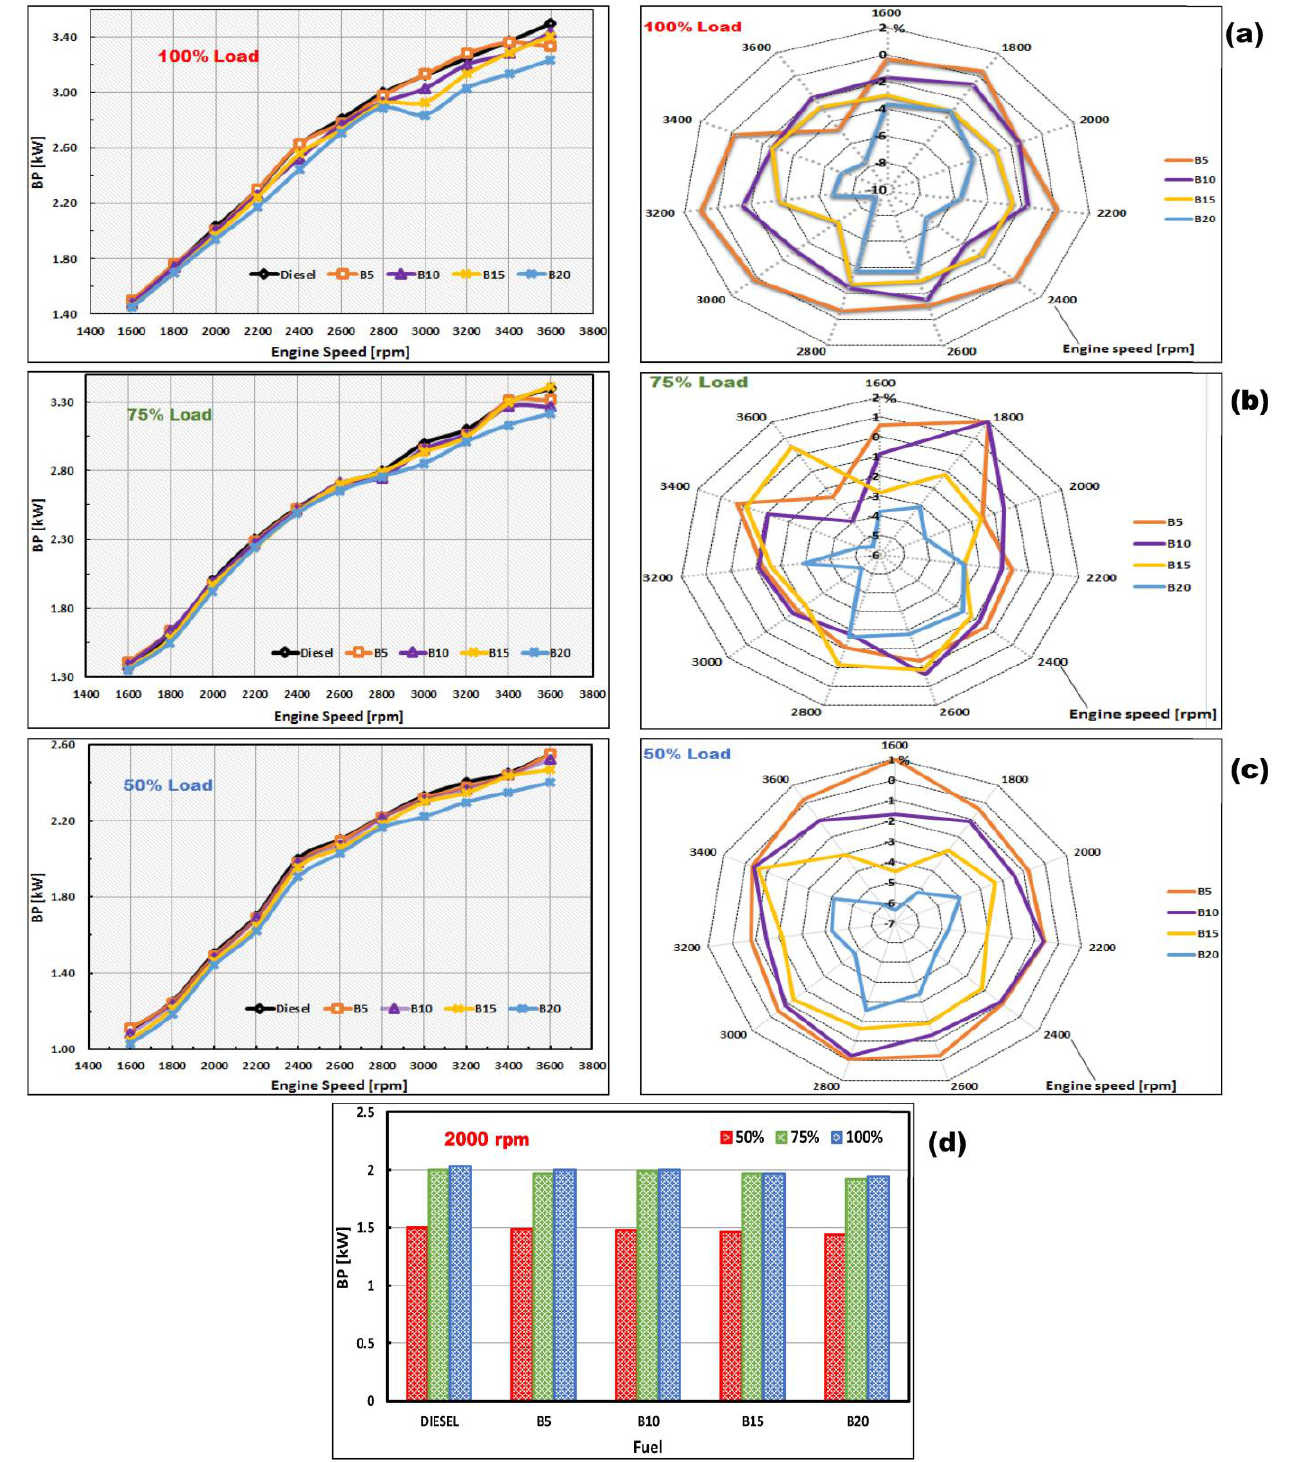
Figure 6. Brake power variation with engine speed, presented as trends (left) and normalized value contours (right) for: (a) 100% load, (b) 75% load, and (c) 50% load; (d) compares all fuels and loads contours (right) for: ( a ) 100% load, ( b ) 75% load, and ( c ) 50% load; ( d ) compares all fuels and loads at at 2000 rpm. 2000